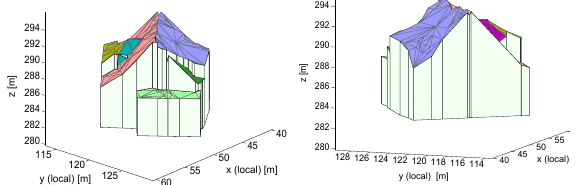
(b) One hyperpoint (dots) com- (c) 3D model resulting from erro- puted for each cell of the col- neous hyperpoint connection. An lapsed quadtree. Erroneously additional (wrong) rooftop trian- connected hyperpoints of neigh- gle due to wrong hyperpoint con- boring quadtree cells (right ar- nection (right part), and a “stand- row), and of non-neighboring hy- alone wall” due to missing hyper- perpoints (left arrow). point connection (left). Figure 10. Errors due to connectivity of hyperpoints from (non)- neighboring quadtree